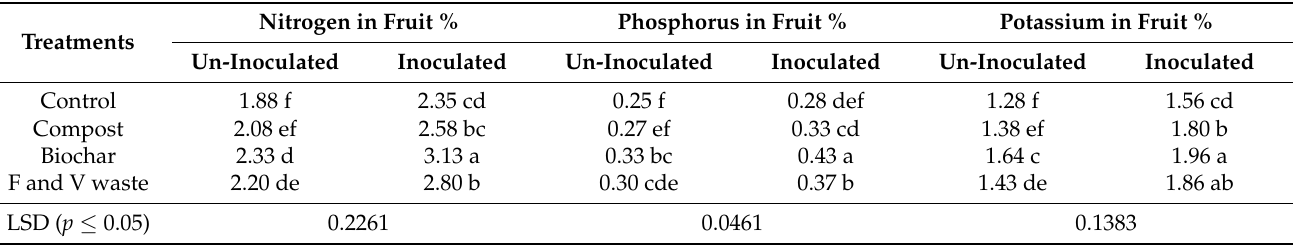
Table 5. Effect of compost, biochar, fruit and vegetable waste (F and V waste) and Bacillus subtilis SMBL 1 on N, P, K in fruit of